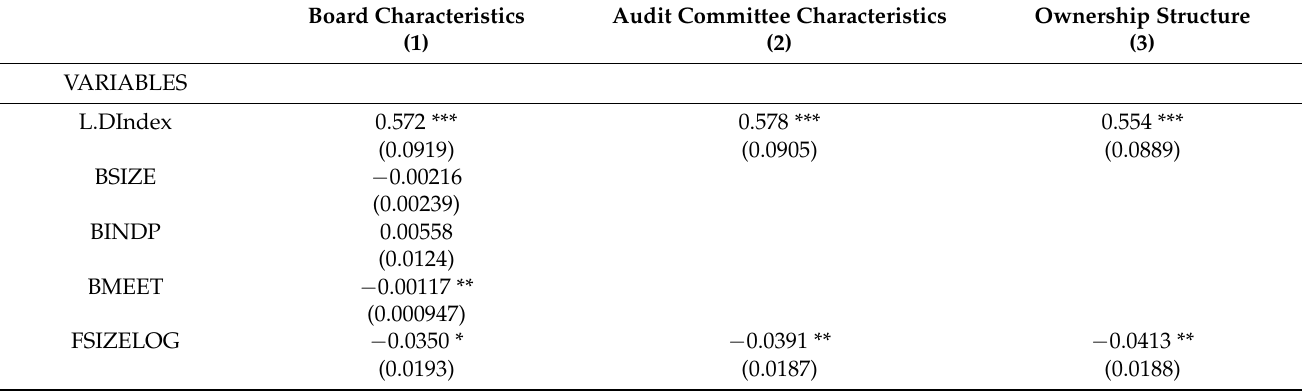
Table 8. GMM models for the three categories of explanatory variables